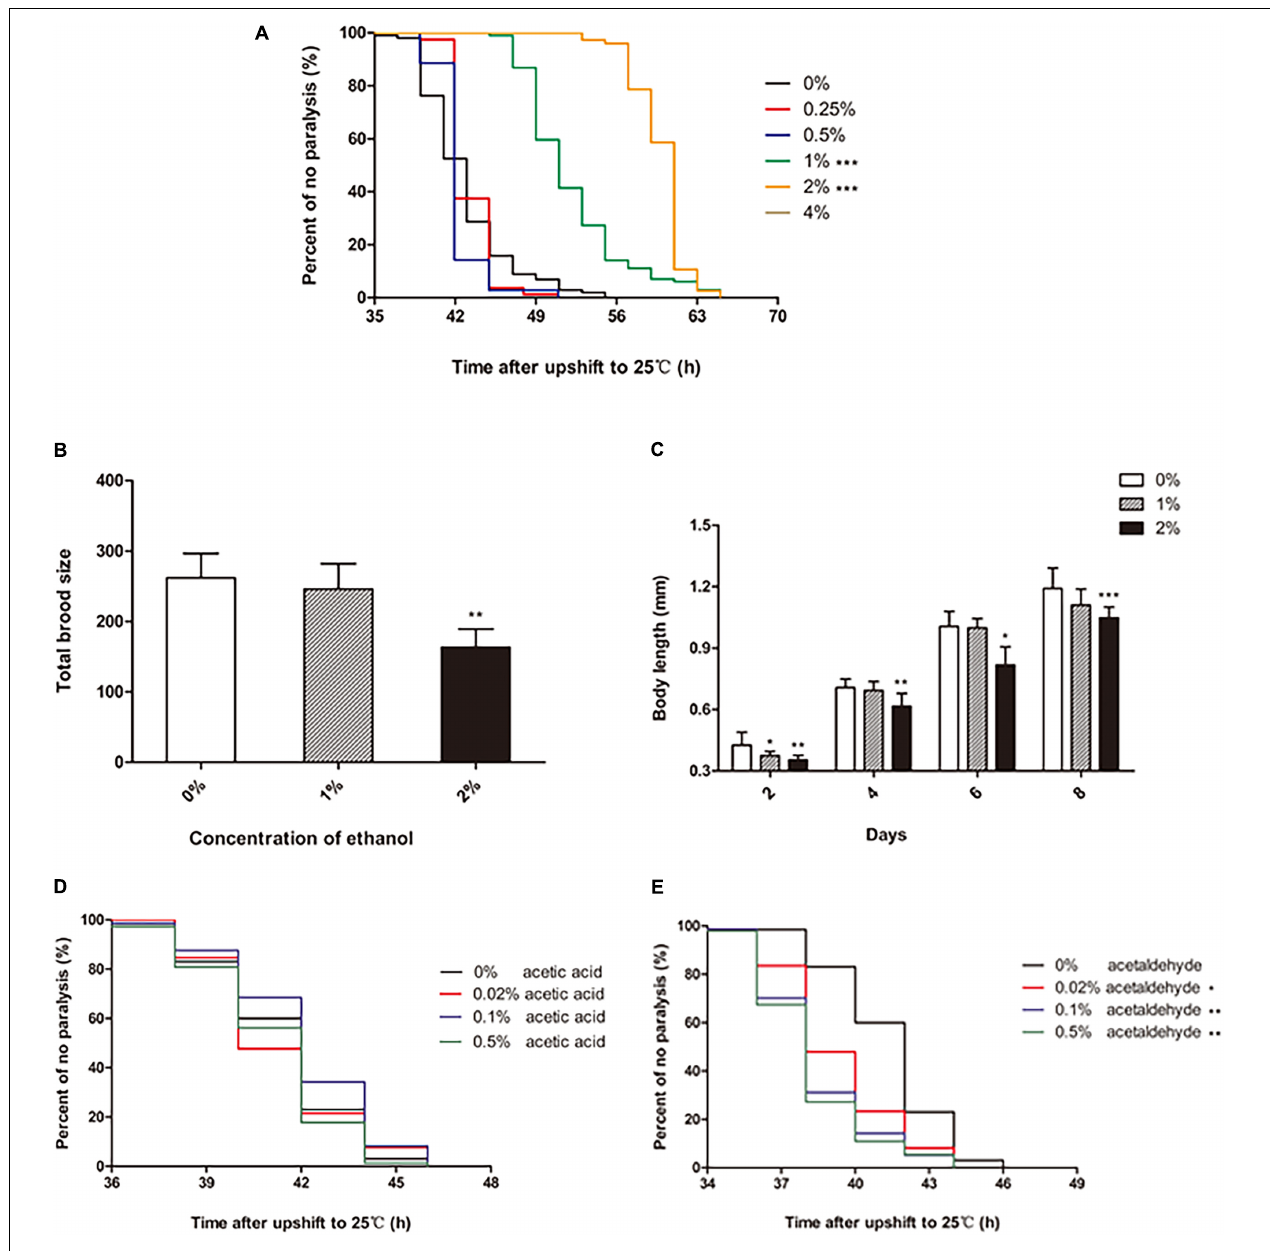
FIGURE 1 | Effect of ethanol on the paralysis of CL4176 C. elegans . (A) Worms were treated with different concentrations of ethanol [0.25%, 0.5%, 1%, 2%, 4%, 6%, 8%, 10% (v/v)] or 0% as control. Data represents the paralysis analysis of C. elegans at each concentration of ethanol, n > 100. (B) Total brood size was measured by counting the number of eggs that each worm laid. Each column represents mean ± SD, n > 10. (C) Body length was determined by microscopy on the days of the lifespan as shown, n > 10. (D) Worms were treated with different concentrations of acetic acid [0.02, 0.1, and 0.5% (v/v)] or 0% as control. Data represents the paralysis analysis of C. elegans at each concentration of acetic acid, n > 100. (E) Worms were treated with different concentrations of acetaldehyde [0.02, 0.1, and 0.5% (v/v)] or 0% as control. Data represents the paralysis analysis of C. elegans at each concentration of acetaldehyde, n > 100. * p < 0.05, ** p < 0.01 and *** p <